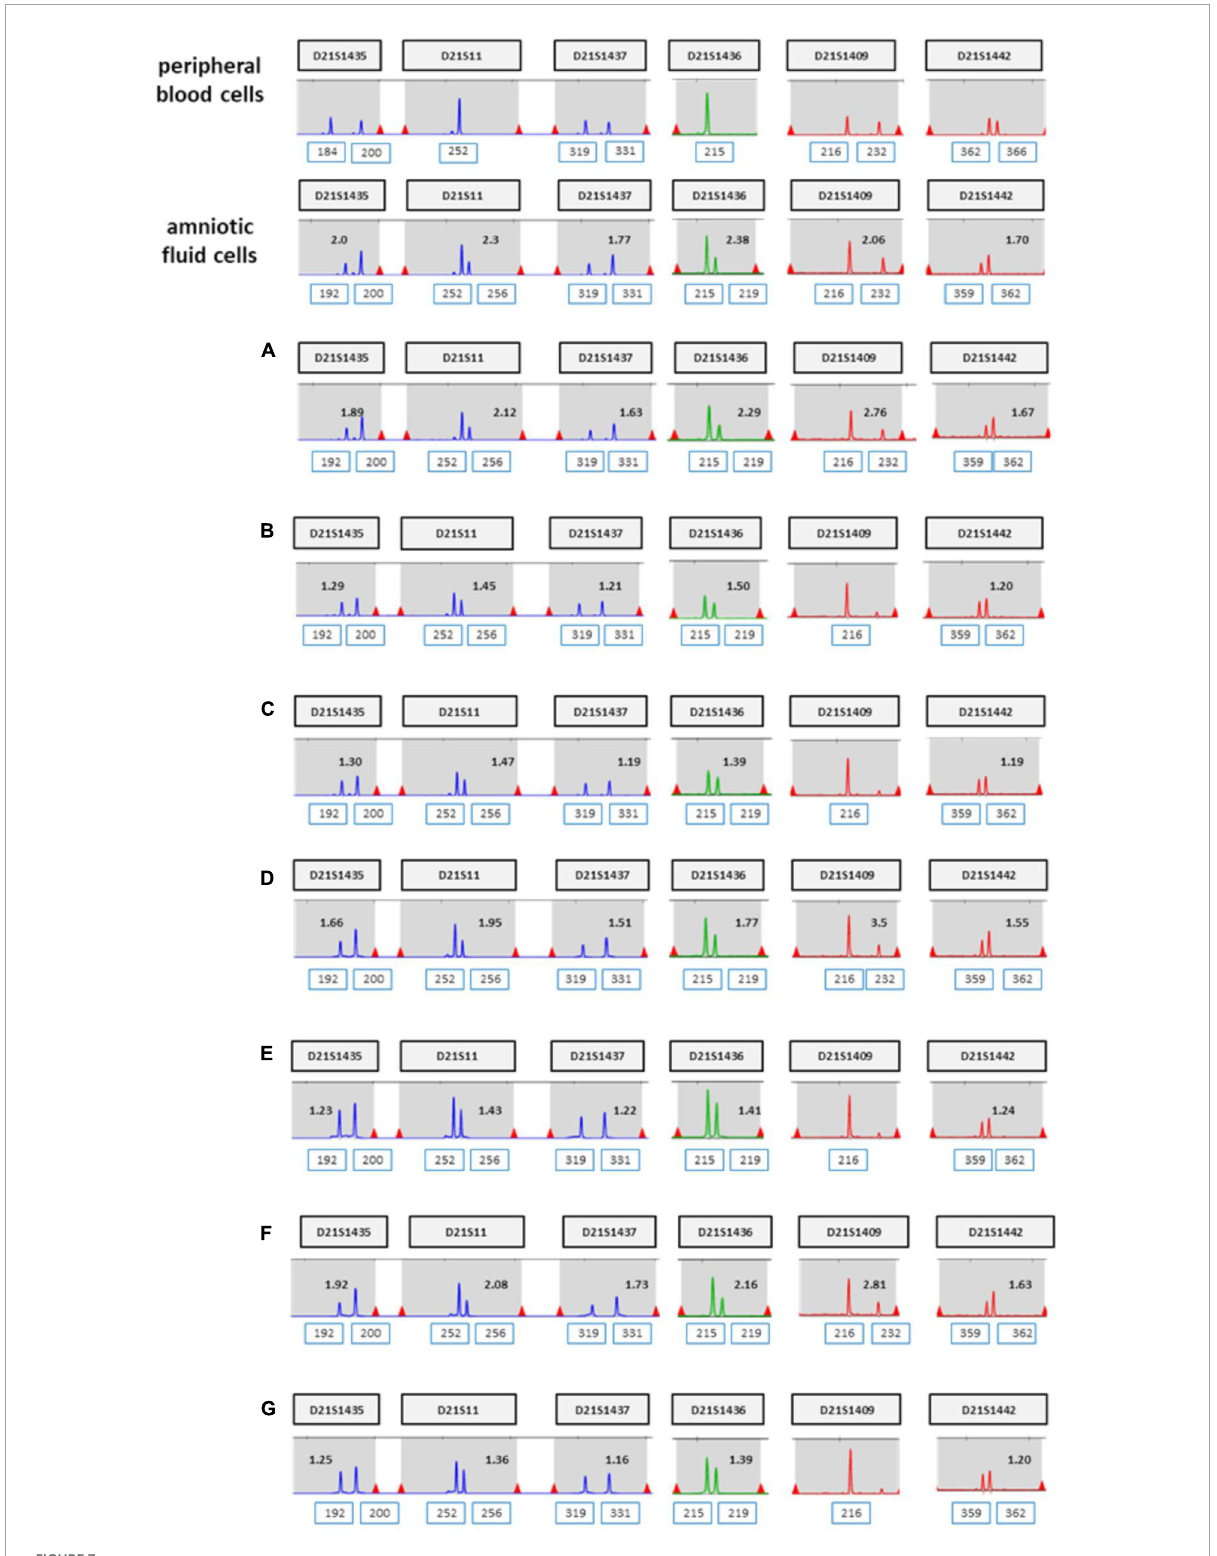
FIGURE7 (A–G) QF-PCR result for chromosome 21 sampling each location of placenta in case 2 (A) cord blood, (B) chorion, (C) villus parenchyma (fetal side section), (D) villus parenchyma (middle section), (E) villus parenchyma (maternal side section I), (F) villus parenchyma (maternal side section II), (G)